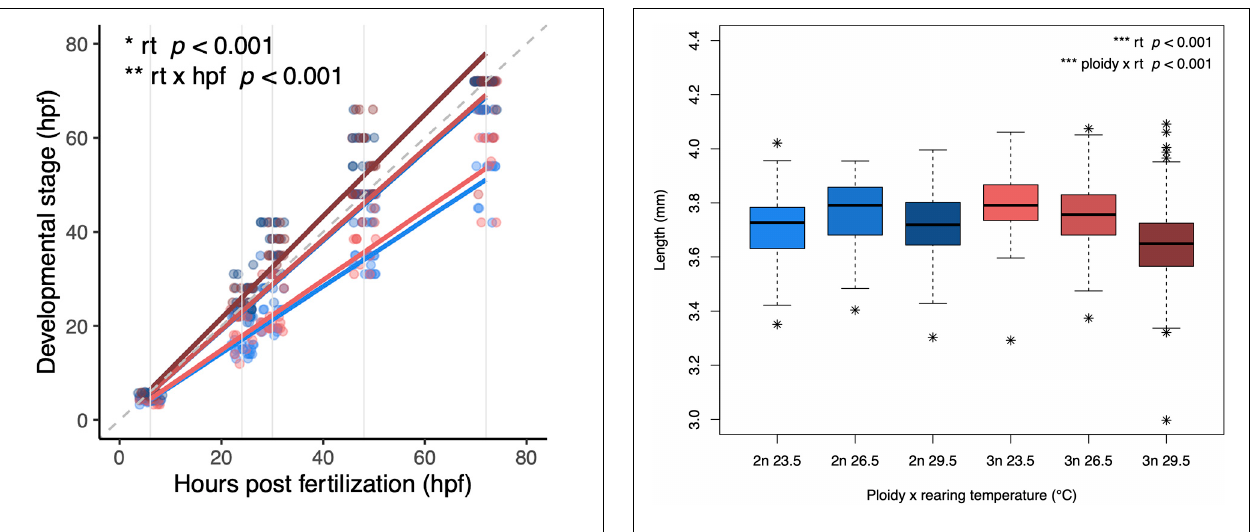
FIGURE 5 | Body length of diploid and triploid larvae reared at different temperatures. Body length was determined at the developmental stage of 5 dpf. The box extends from the lower quartile to the upper quartile of the data, spanning the inter-quartile range (IQR). The thick line within the box represents the median. Whiskers extend to minima and maxima, but are limited to data points 1.5 times outside the IQR. The asterisks represent outliers. The effect of rearing temperature and the interaction between rearing temperature and ploidy level were significant (ANOVA, p < 0.001, n =